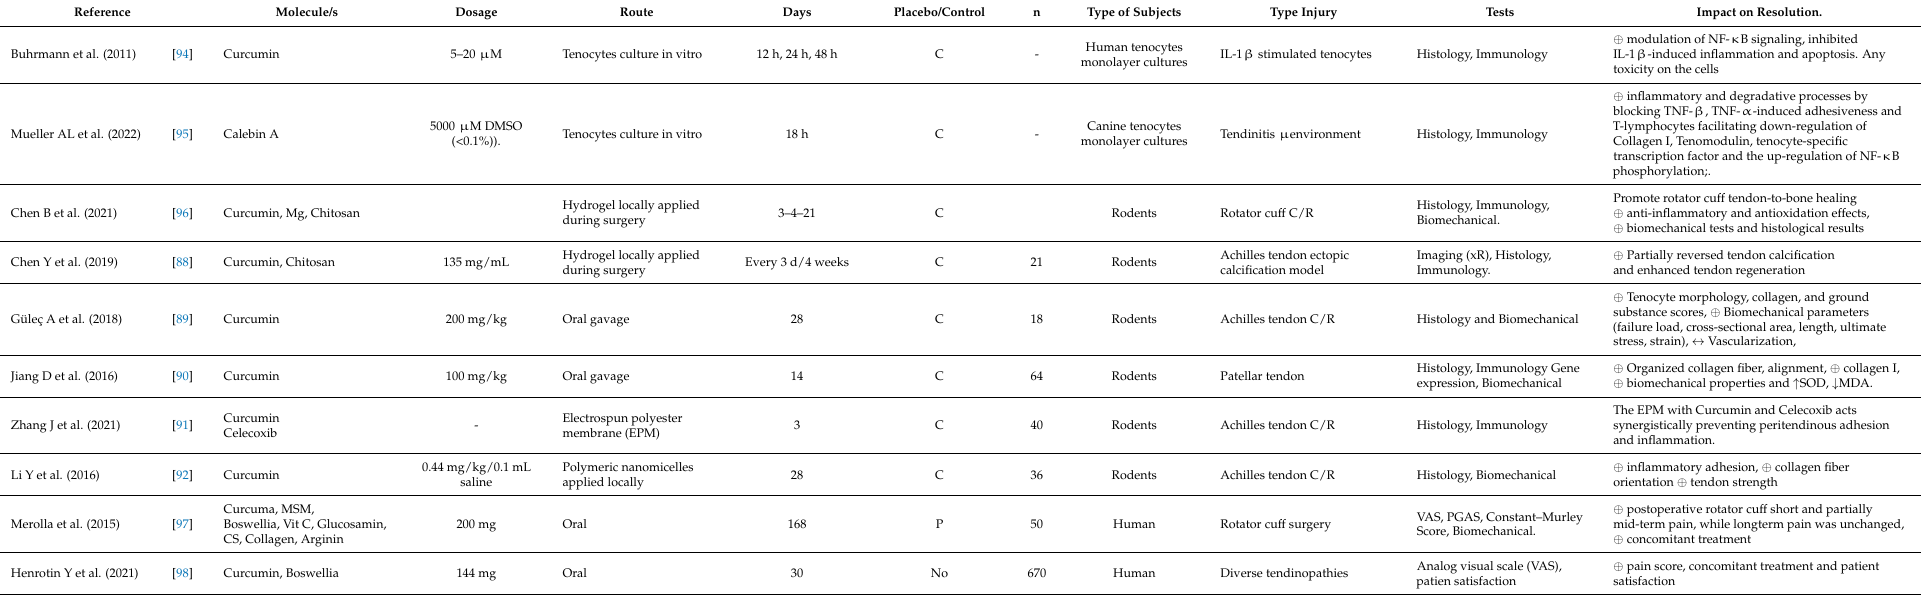
Table 3. Studies evaluating the effect of curcumin in